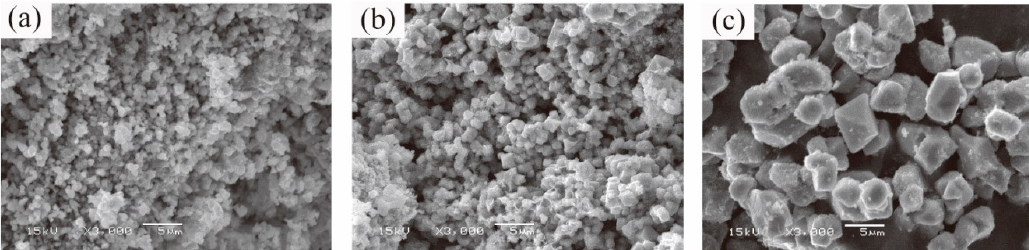
Figure 2. SEM images of the starting material (MnS) and synthesized minerals. ( a ) MnS, ( b ) alabandite synthesized at 500 °C and 100 MPa (run no. 510), and ( c ) alabandite synthesized at 800 °C and 100 MPa (run no. 813).